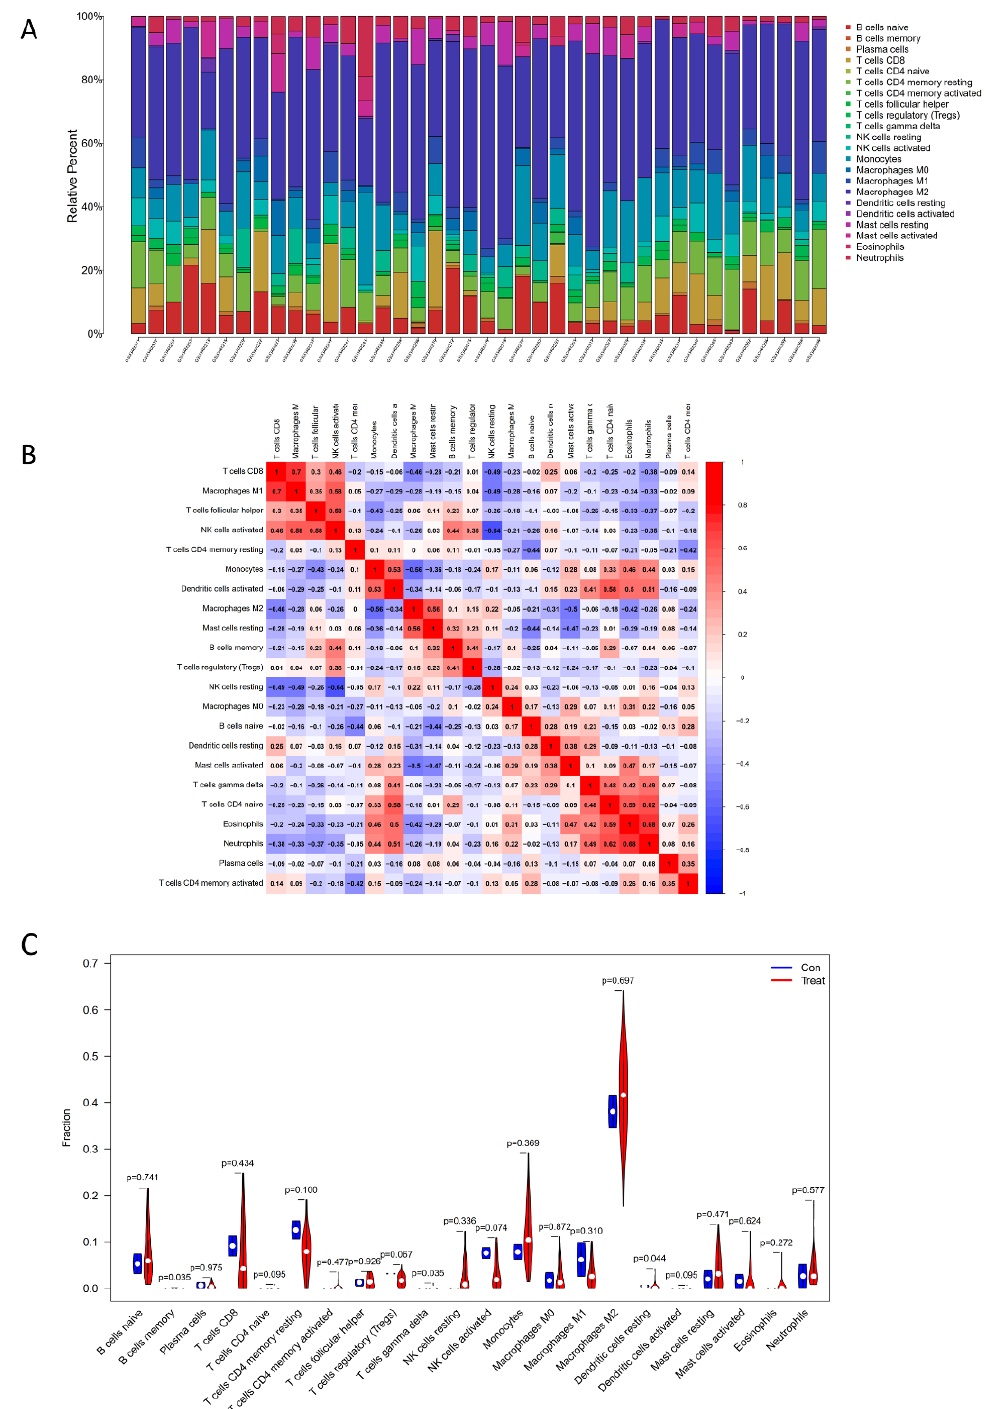
Figure 4. The fraction of the immune cells in the BA and control groups. ( A ) The bar chart indicates the distribution of the 22 subsets of immune cells. X-axis: each GEO sample; y-axis: percentage of each kind of immune cell. ( B ) The correlation analysis of different immune cells. The red color represents positive correlation and the blue color represents negative correlation. ( C ) The violin graph shows the difference in immune infiltration between BA and normal groups. The BA group is shown in blue and normal group is shown in red. p -value < 0.05.